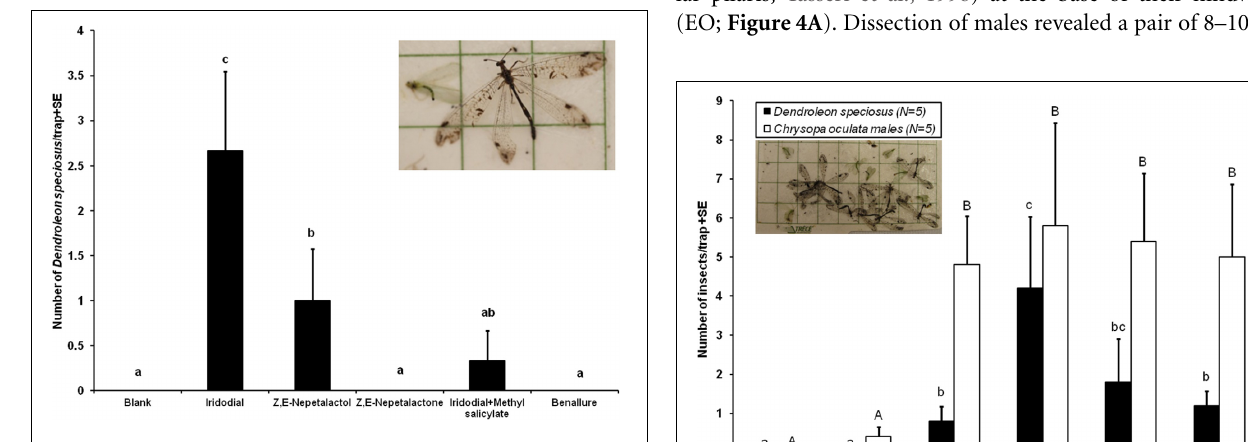
FIGURE 1 | Field response of Dendroleon speciosus females and males to a pheromone compound (iridodial) of green lacewings (Neuroptera: Chrysopidae: Chrysopa spp.), two pheromone components of aphids (Z,E-nepetalactone and Z,E-nepetalactol), a commercial lure for lacewings and other beneficial insects (Benallure™), and unbaited control traps ( N = 3; treatments loaded on rubber septa as described in test; 28 July to 4 August 2004, Spokane, WA, USA). Bars with the same letter were not statistically different ( P > 0 . 05) by the Student–Newman–Keuls all pairwise comparisons after the nonparametric Kruskal–Wallis ANOVA on rank test.